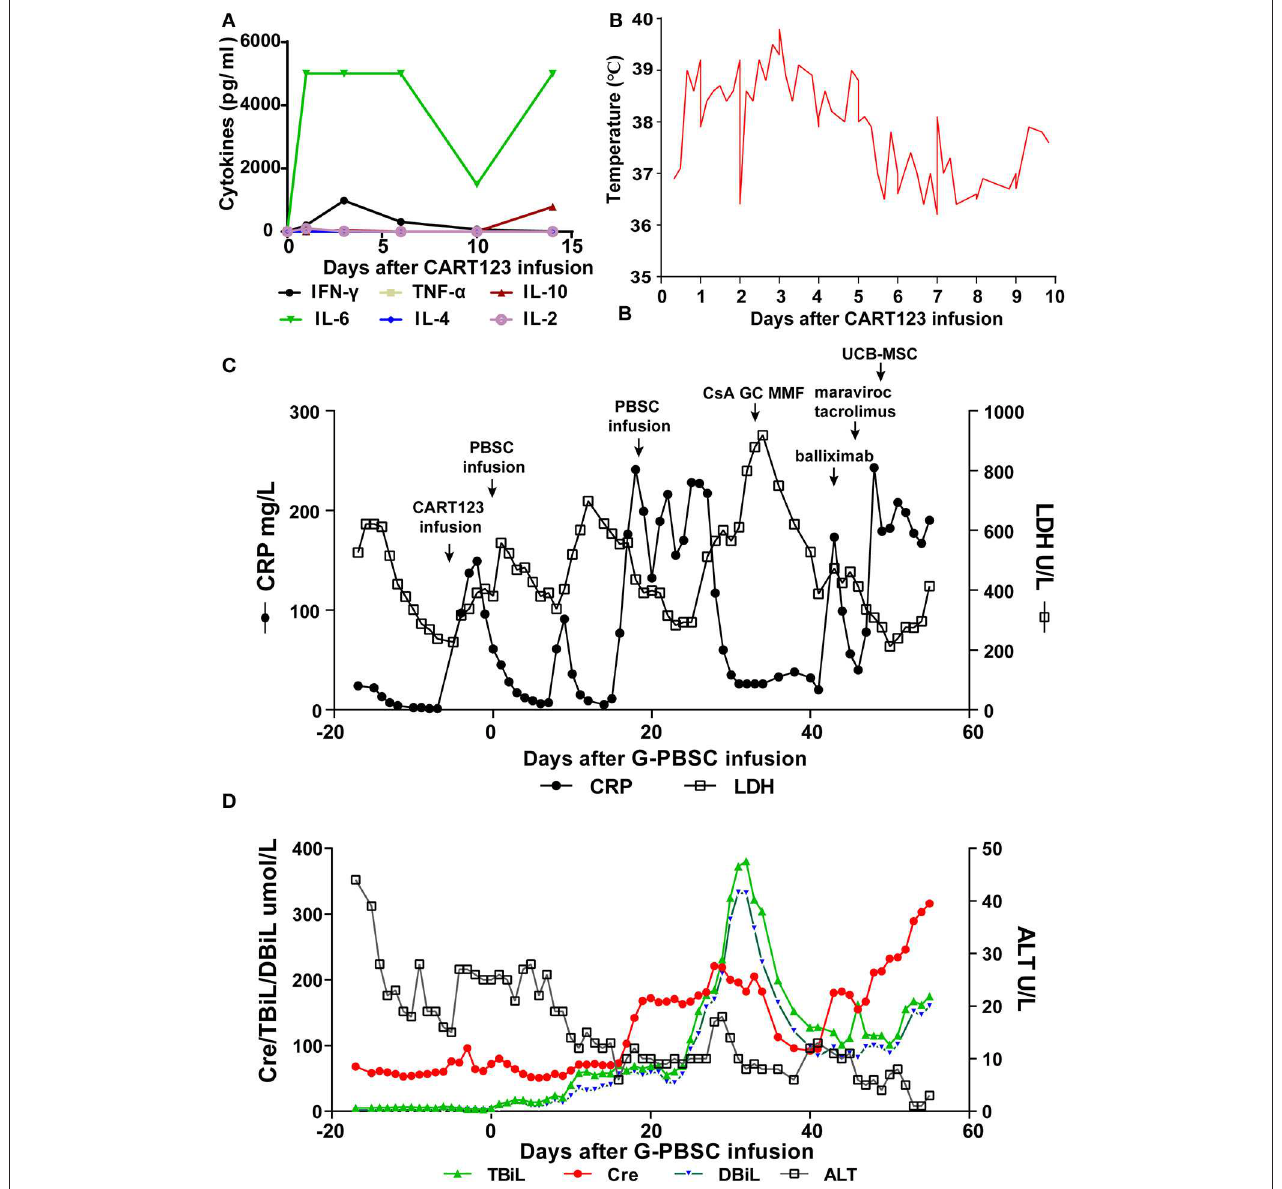
FIGURE 4 | Trends of serum cytokines, body temperature, and major blood biochemical indexes after CART123 infusion. (A) Cytokines changed after CART123 infusion. Serum cytokine levels were measured at the indicated time points before or after CART123 and PBSC infusions. (B) Changes in body temperature after CART123 infusion. (C) Changes in CRP and LDH levels after G-PBSC infusion. (D) Changes in Cre, TBiL, DBiL, and ALT levels after G-PBSC infusion. CART123, CD123-targeted chimeric antigen receptor (CAR) T cell; PBMC, peripheral blood mononuclear cell; IL, interleukin; IFN, interferon; TNF, tumor necrosis factor; CRP, C-reactive protein; ALT, Alanine transaminase; aGVHD, acute graft-vs-host disease; CsA, Cyclosporine A; MMF, mycophenolate mofetil; GC, glucocorticoids; UCB-MSC, umbilical cord blood mesenchymal stem cells; DIC, disseminated intravascular coagulation; LDH, lactate dehydrogenase; Cre, creatinine; TBiL, total bilirubin; DBiL, direct